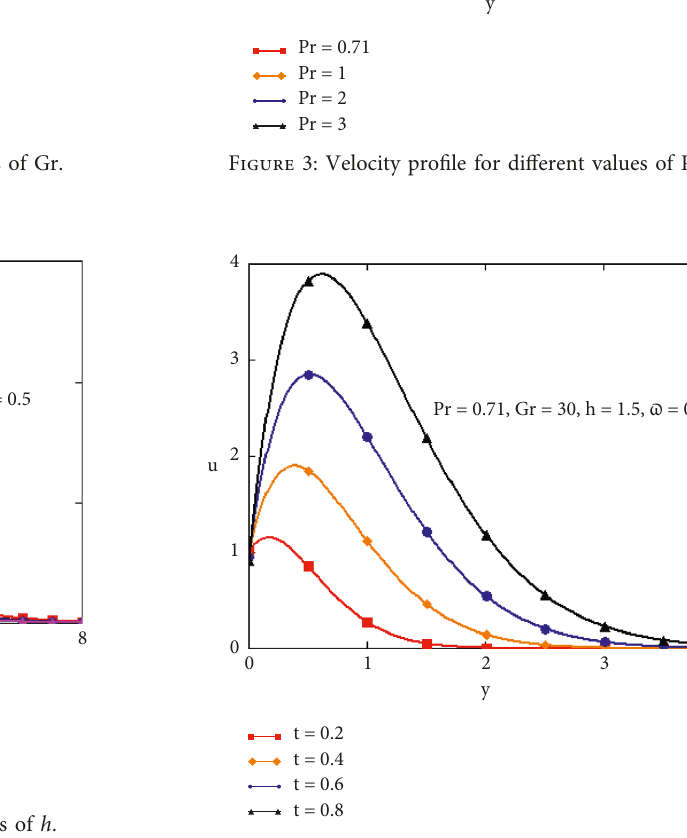
Figure 4: Velocity profile for different values of t